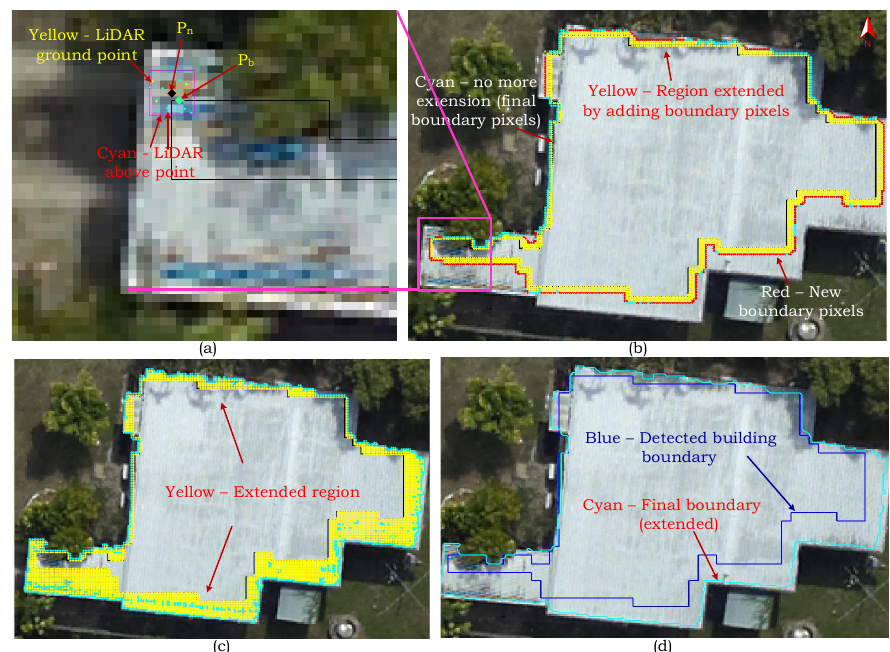
Figure 9. Pixel-based enlargement process: ( a ) Candidate boundary pixel ( P n ) selection; ( b ) Snapshot of the accumulated pixels; ( c ) Extended region; and ( d ) Detected outline and final building boundary.